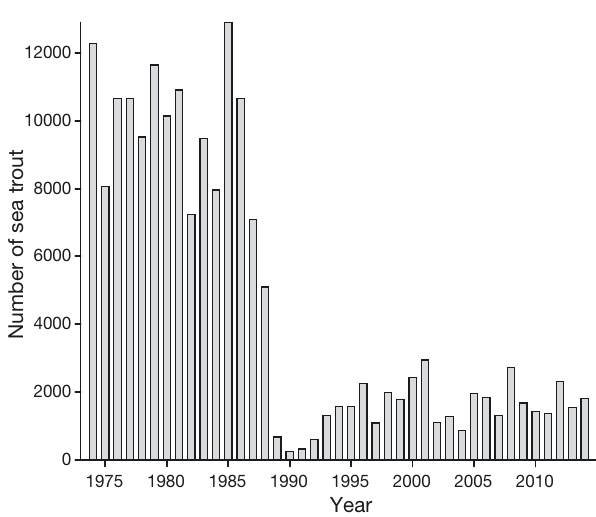
Fig. 4. Sea trout rod catches for 18 fisheries in the Conne - mara district in western Ireland during 1974−2014. Data